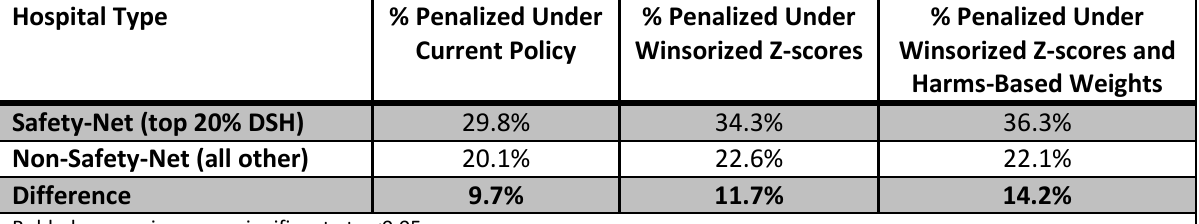
Table 6.24: Percent Penalized under Winsorized Z-scores and Harms-Based Weights